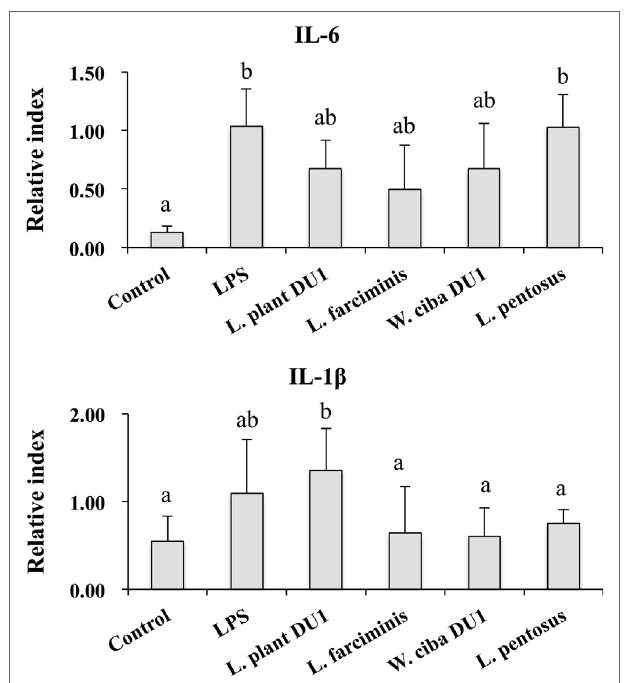
FigUre 4 | Lactic acid bacteria (LAB) strains altered the production of immunoregulatory and fibrogenic cytokine in THP-1 cells co-cultured with HepG2 cells. In the co-culture setup, the apical side that contain HepG2 cells were stimulated with heat-killed LABs for 48 h, after which THP-1 cells that taken in the basolateral side was treated with LPS for 12 h. The expressions of IL-10 and TGF- β at mRNA levels were determined by RT-PCR. Cells treated with either medium or LPS alone were used as controls. The results presented as an average values (mean ± SD) of three independent experiments. Different superscript letters indicate significant differences at the 0.05 level.